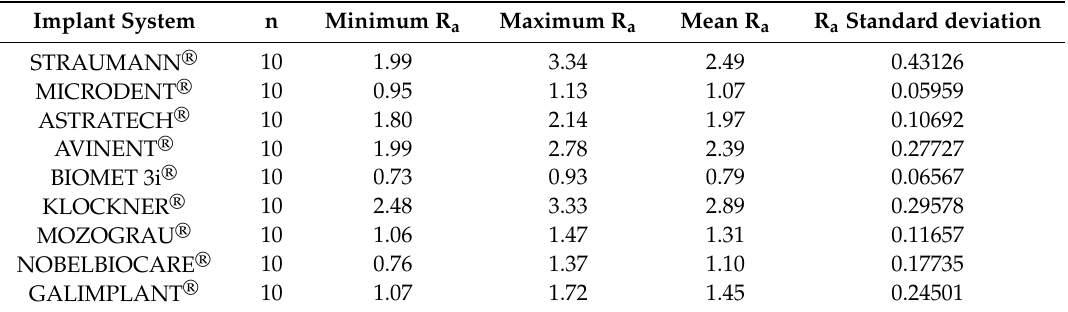
Table 3. Sample number (n), minimum R a , maximum R a , mean R a , and R a standard deviation of each experimental group.